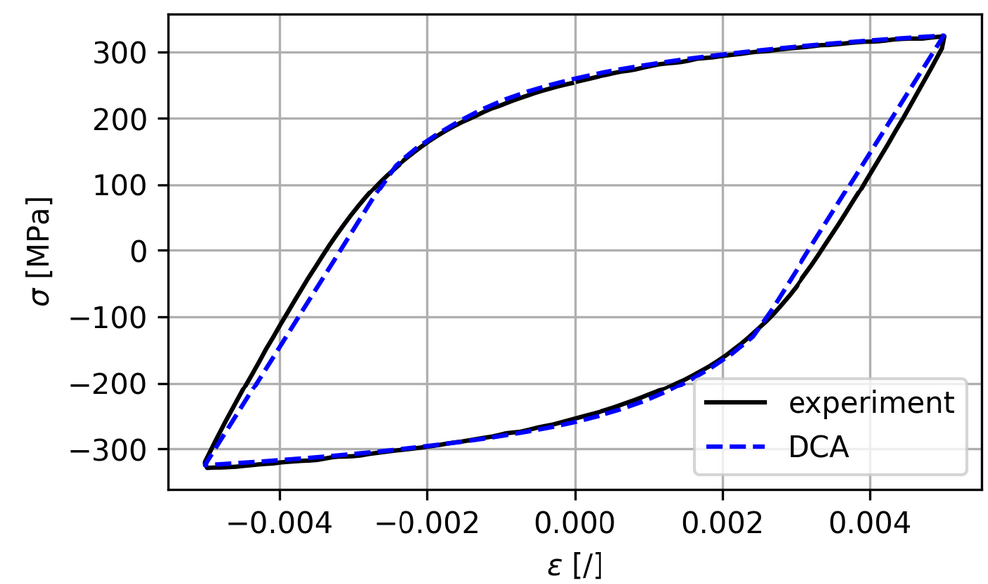
Figure 3. Comparison of DCA and stabilized experimental hysteresis curve at 0.5% (cid:101) a and R (cid:101) = − 1.